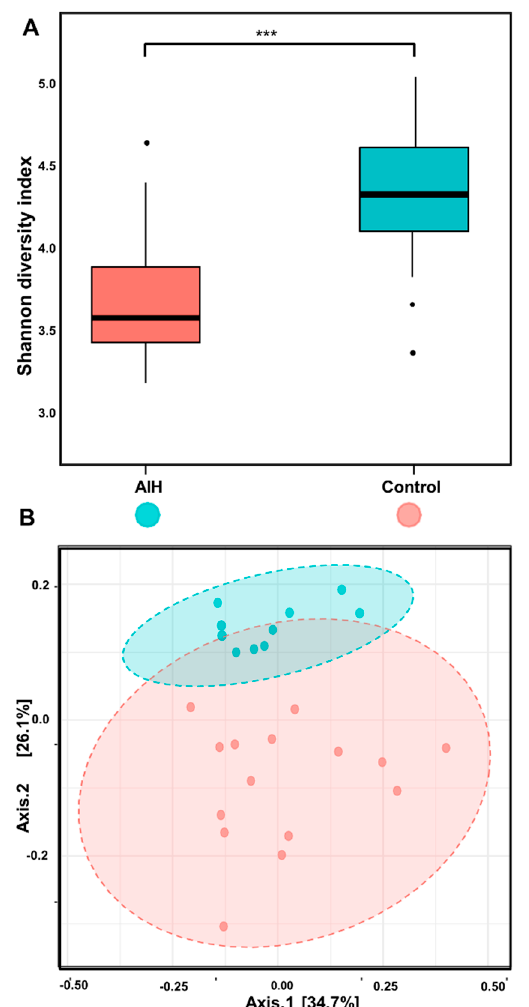
Figure 1. Bacterial diversity analysis of gut microbiota. ( A ) Alpha diversity index (Shannon diversity index) was represented as box plots of (a) for each study group. The median was defined as the line inside each box while interquartile range (IQR) between the25th and 75th percentile was delimited by the outer box. The x -axis shows study groups and the y -axis represents the Shannon index. A nonparametric Wilcoxon rank sum test was estimated to highlight the statistical significance of pairwise comparisons which was symbolized as either (ns <1), *** p < 0.001. ( B ) Principal coordinate analysis (PCoA) based on weighted UniFrac distance matrix of gut microbial community structures for patients and controls. The first and second coordinates were visualized by the x - and y -axes, respectively. Community variations were explained by the percentages in parentheses on each axis 34.7% and 26.1%, respectively. Ellipses indicate significant clustering ( p -value <0.001, permutational multivariate analysis of variance (PERMANOVA)) according to age. Green and red circles represent healthy controls and patients with autoimmune hepatitis, respectively.